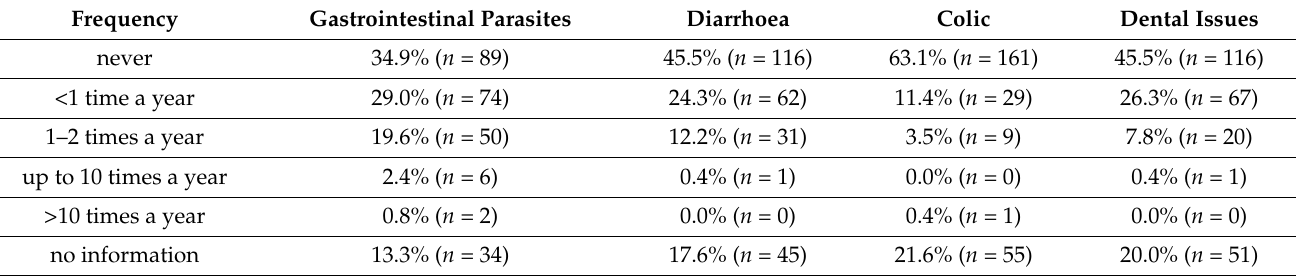
Table 6. Observation of the owners: frequency of diseases or symptoms affecting the digestive system ( n = 255).